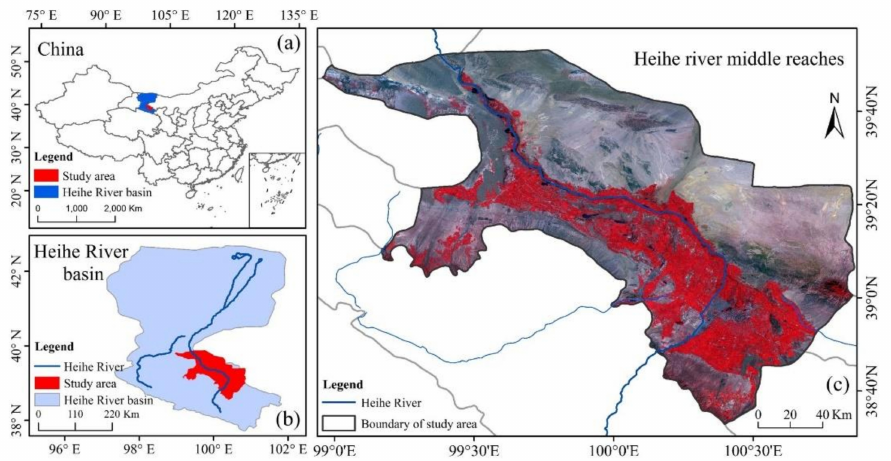
Figure 1. Study area of the middle reaches of Heihe River showing ( a ) location of the study area in China, ( b ) location of the study area in Heihe River basin, ( c ) Sentinel-2 composite image in August of false-color